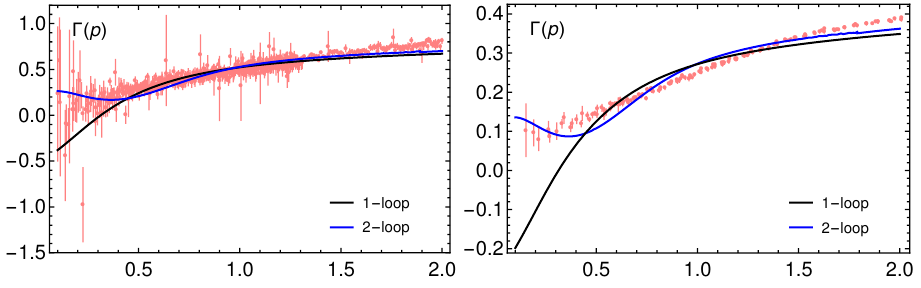
Figure 3. Three-gluon vertex in the one vanishing momentum configuration compared with lattice data from [12] (left) and [28]